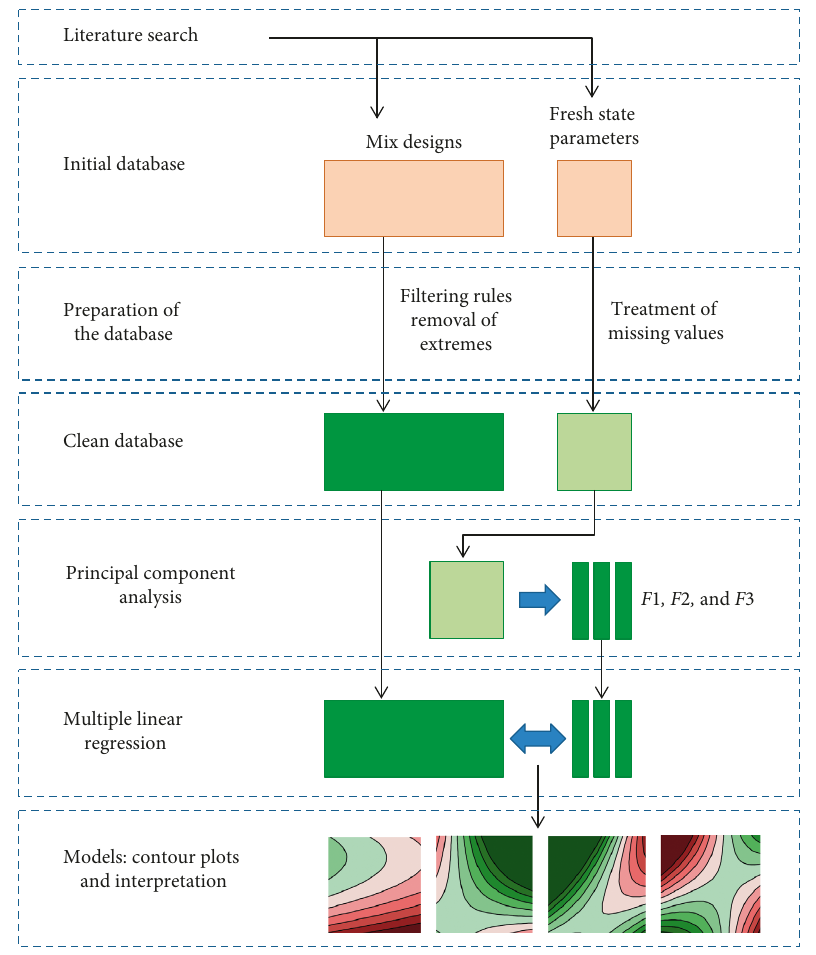
Figure 1: Overview of the methodology followed in this